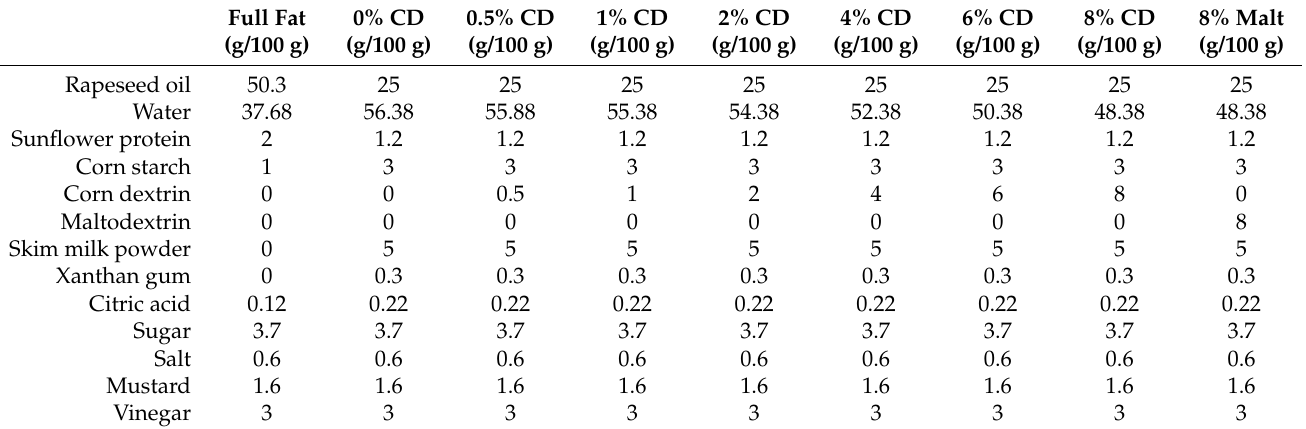
Table 2. Formulations of the mayonnaise samples (CD = corn dextrin, Malt =